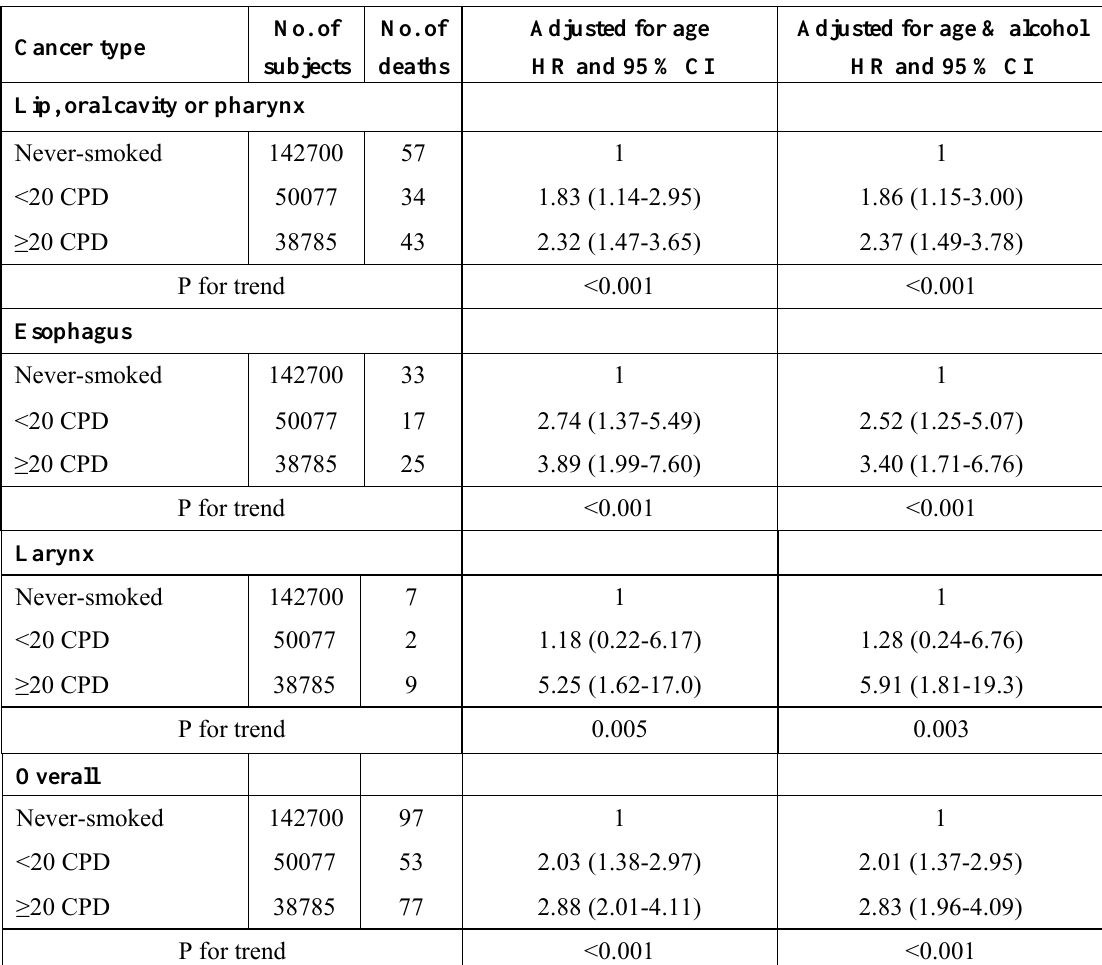
Table 2. Dose-response association between current cigarette smoking and upper aero digestive tract cancers (CPD=cigarettes currently smoked per day, where known). All analyses stratified by sex and